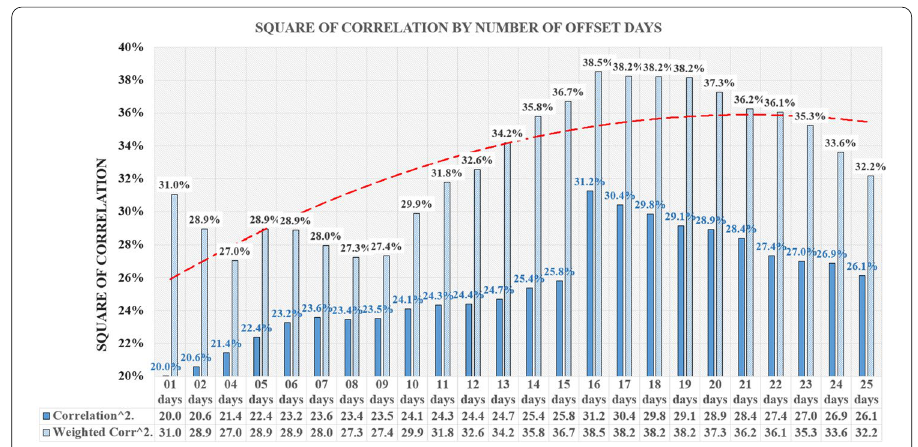
Fig. 6 Square of correlation by number of offset days—all 301 days of analysis